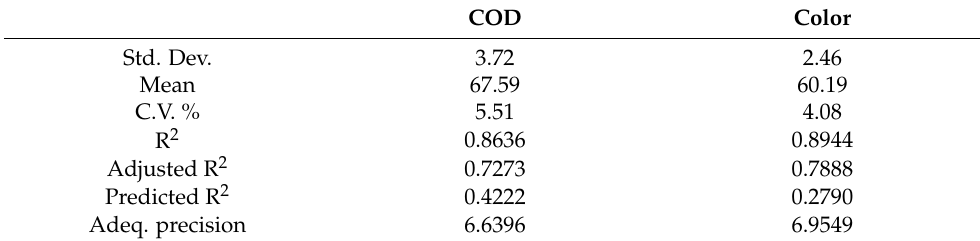
Table 5. Fit statistics.